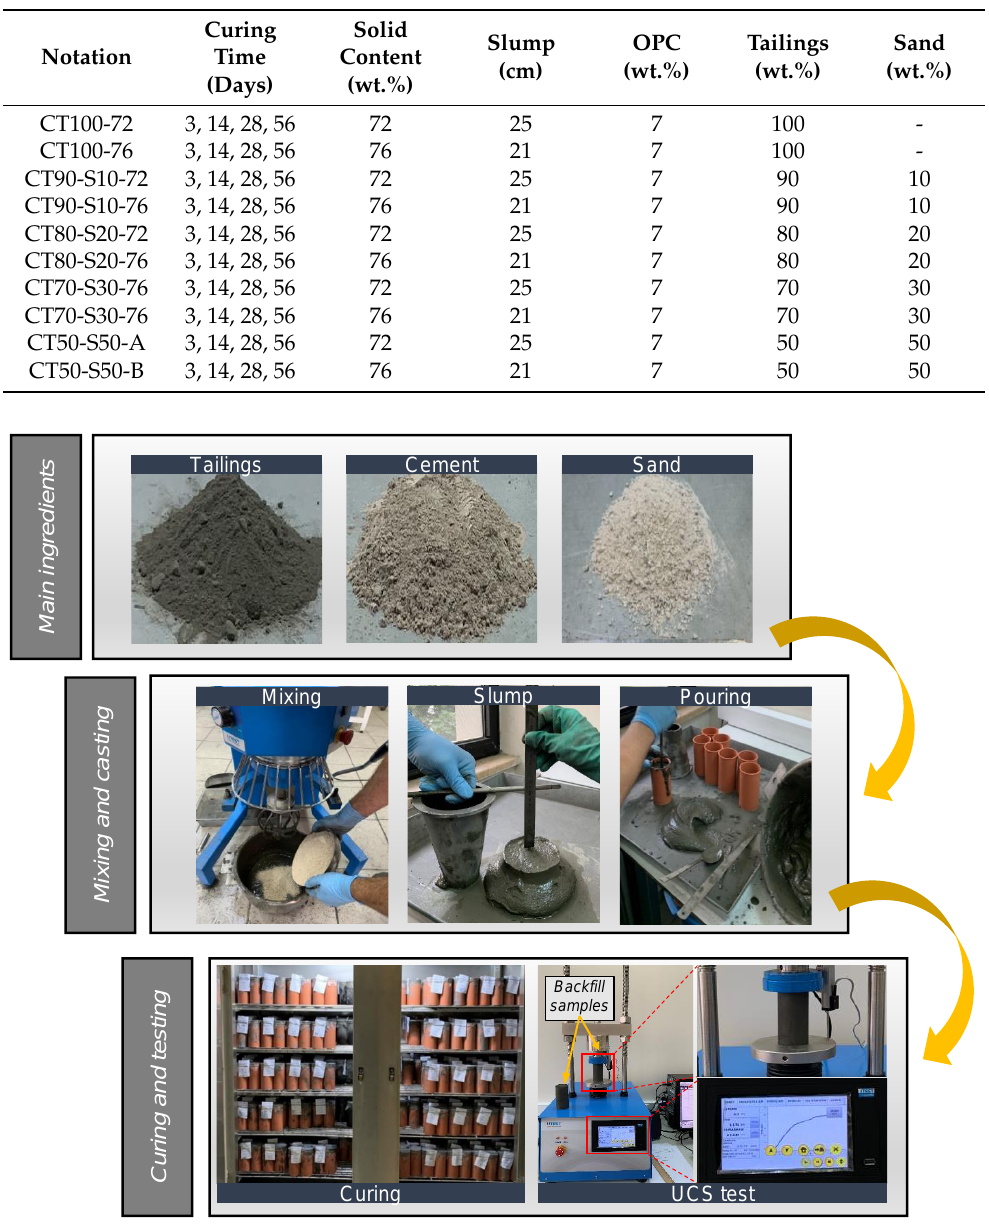
Table 3. CPB recipe design (CT: copper tailings).